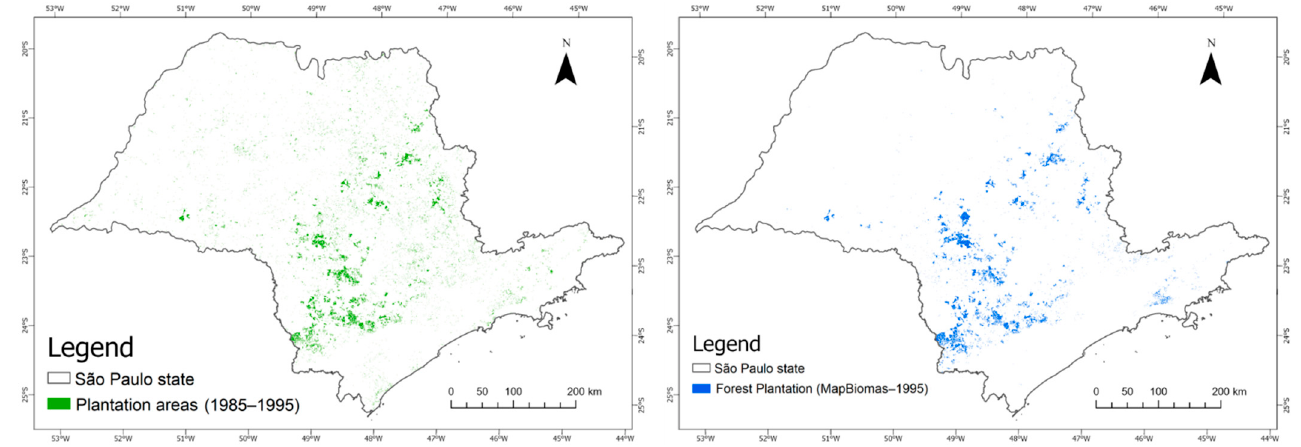
Figure 7. Forest plantation areas obtained by the proposed method ( left side) and forest plantation areas extracted from the MapBiomas product ( right side) for 1995.